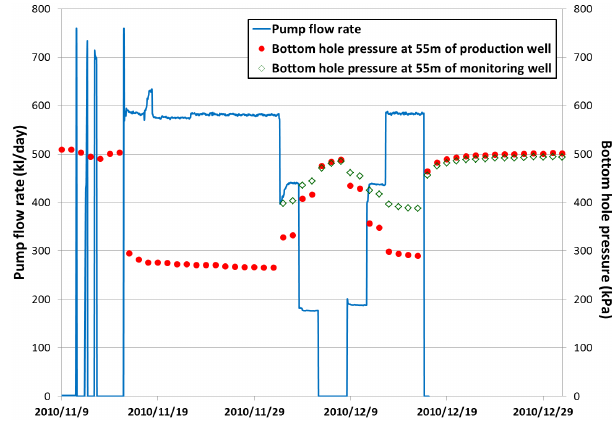
Figure 3. Pump flow rate and bottom hole pressure of each